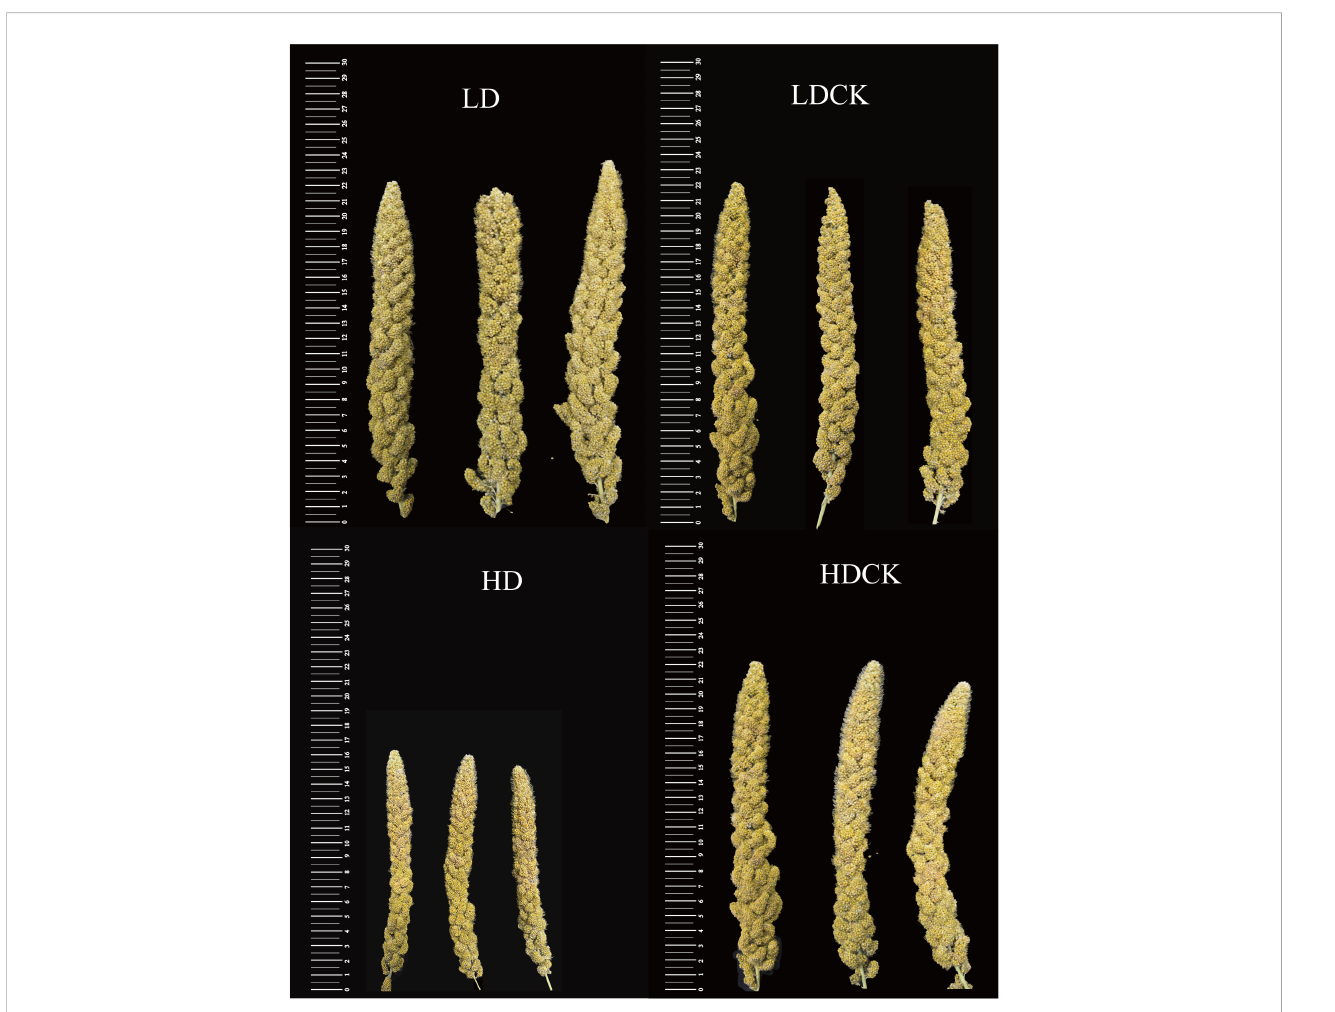
FIGURE 1 The morphology changes of panicle under different drought treatment and